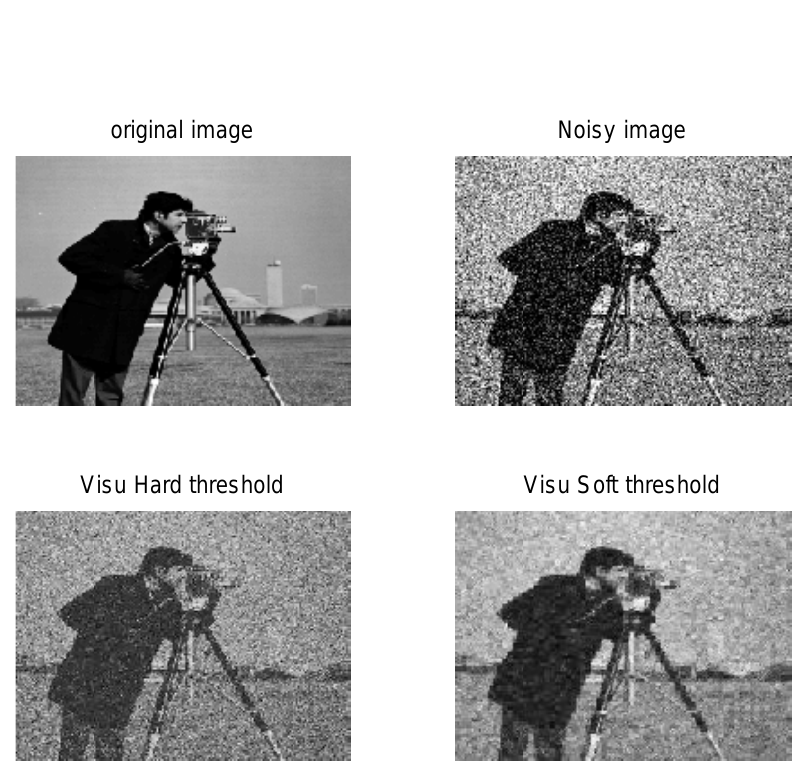
Fig. 3. Denoised cameraman image using Visu thresholding technique for Db1 for the second level of